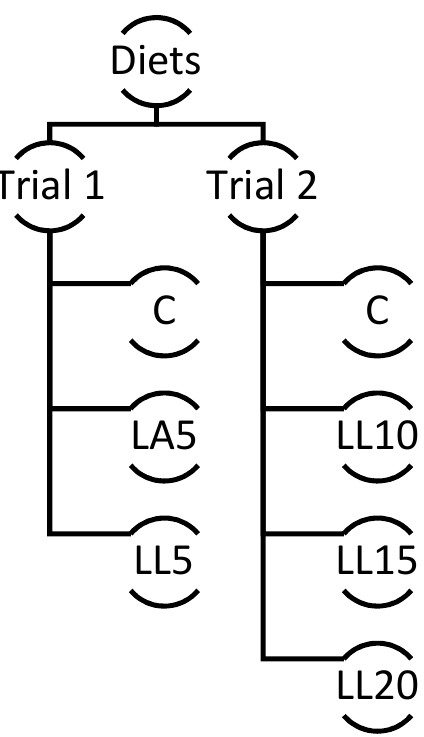
Figure 1. Diagram showing the distribution of diets by trial 1 and trial 2 with an indication of the level of the incorporation of Lupinus albus (LA) and Lupinus luteus (LL). C—control; LL5— Lupinus luteus 50 g/kg; LA5— Lupinus albus 50 g/kg; LL10— Lupinus luteus 100 g/kg; LL15— Lupinus luteus 150 g/kg; LL20— Lupinus luteus 200 g/kg; DM. Details on diet formulation and chemical composition are found in Table 1, which is Table 1. Chemical composition (g/kg DM) and levels of inclusion of diet components (g/kg as fed) of the different treatment diets.